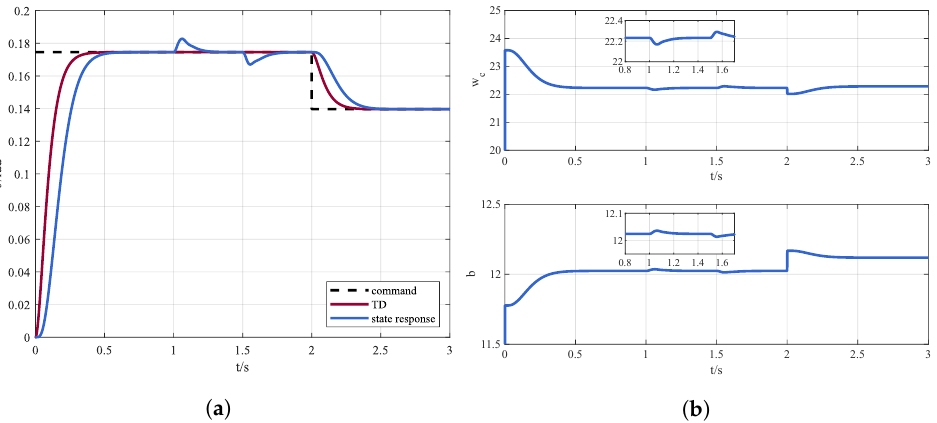
Figure 9. ( a ) Control instruction and state response via DDPG-ADRC in the presence of external disturbances and ( b ) online parameters adjustment in the presence of external disturbances.